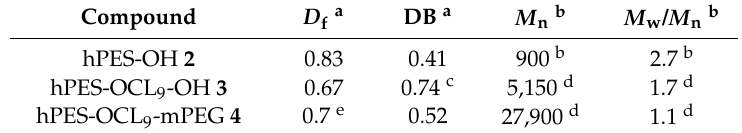
Table 1. Comparison of physical characteristics of CMS with its macroinitiator and